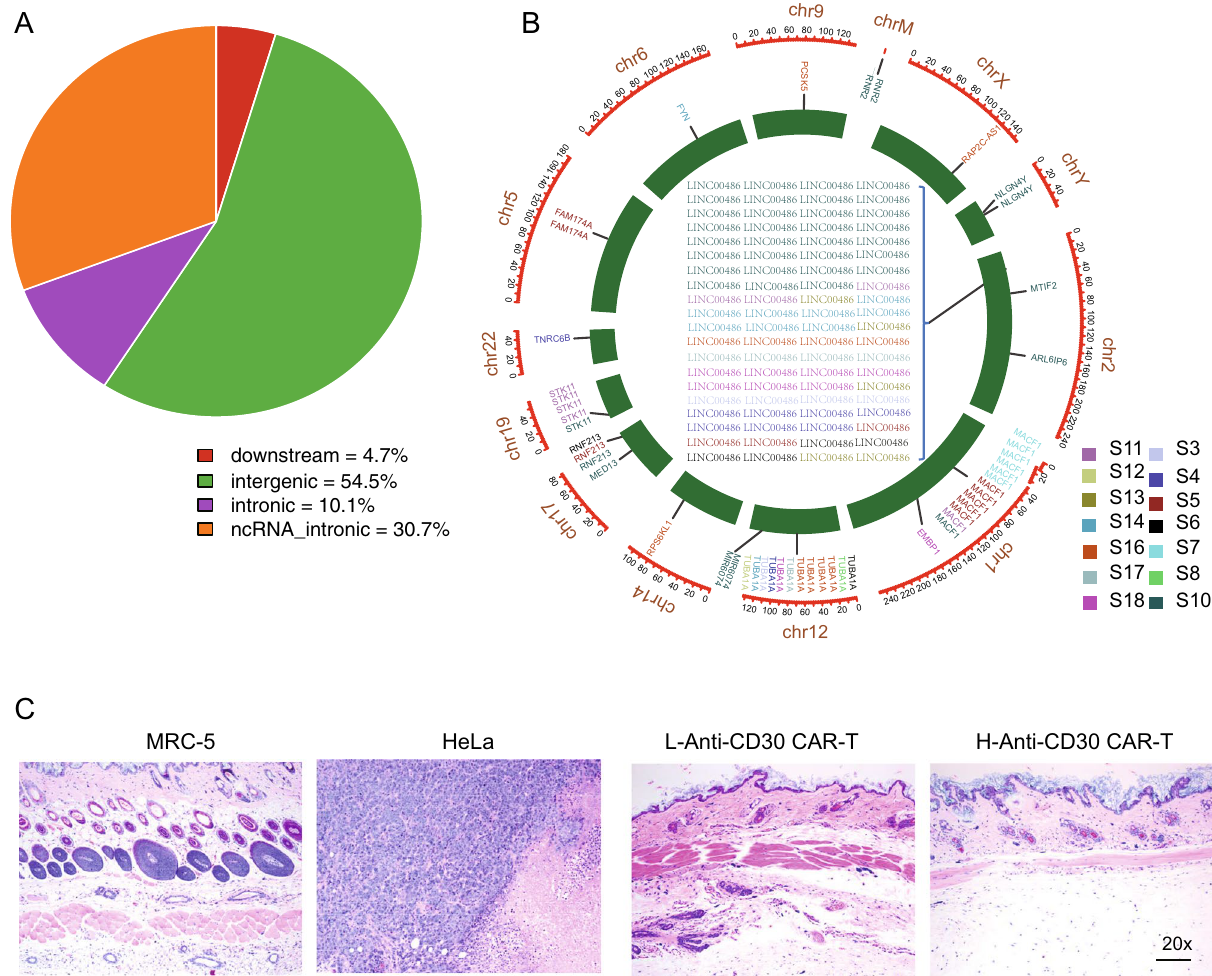
Figure 4. Anti-CD30 CAR-T do not have an increased risk of malignant transformation in vitro or in vivo. (A) The pie chart shows the overall insert integrity of the anti-CD30 CAR T(CD30-28BBz) lentiviral vector. (B) Circos plot visualization of the integration sites across the genome and local genomic features from the inner to outer circles. Genes that harbor these integration sites and the color of the gene names show that the integration sites probably derive from different samples. (C) Analysis of the tumorigenic potential of anti-CD30 CAR T cells (CD30-28BBz). MRC-5 and HeLa were used as the negative and positive control, respectively. H&E-stained